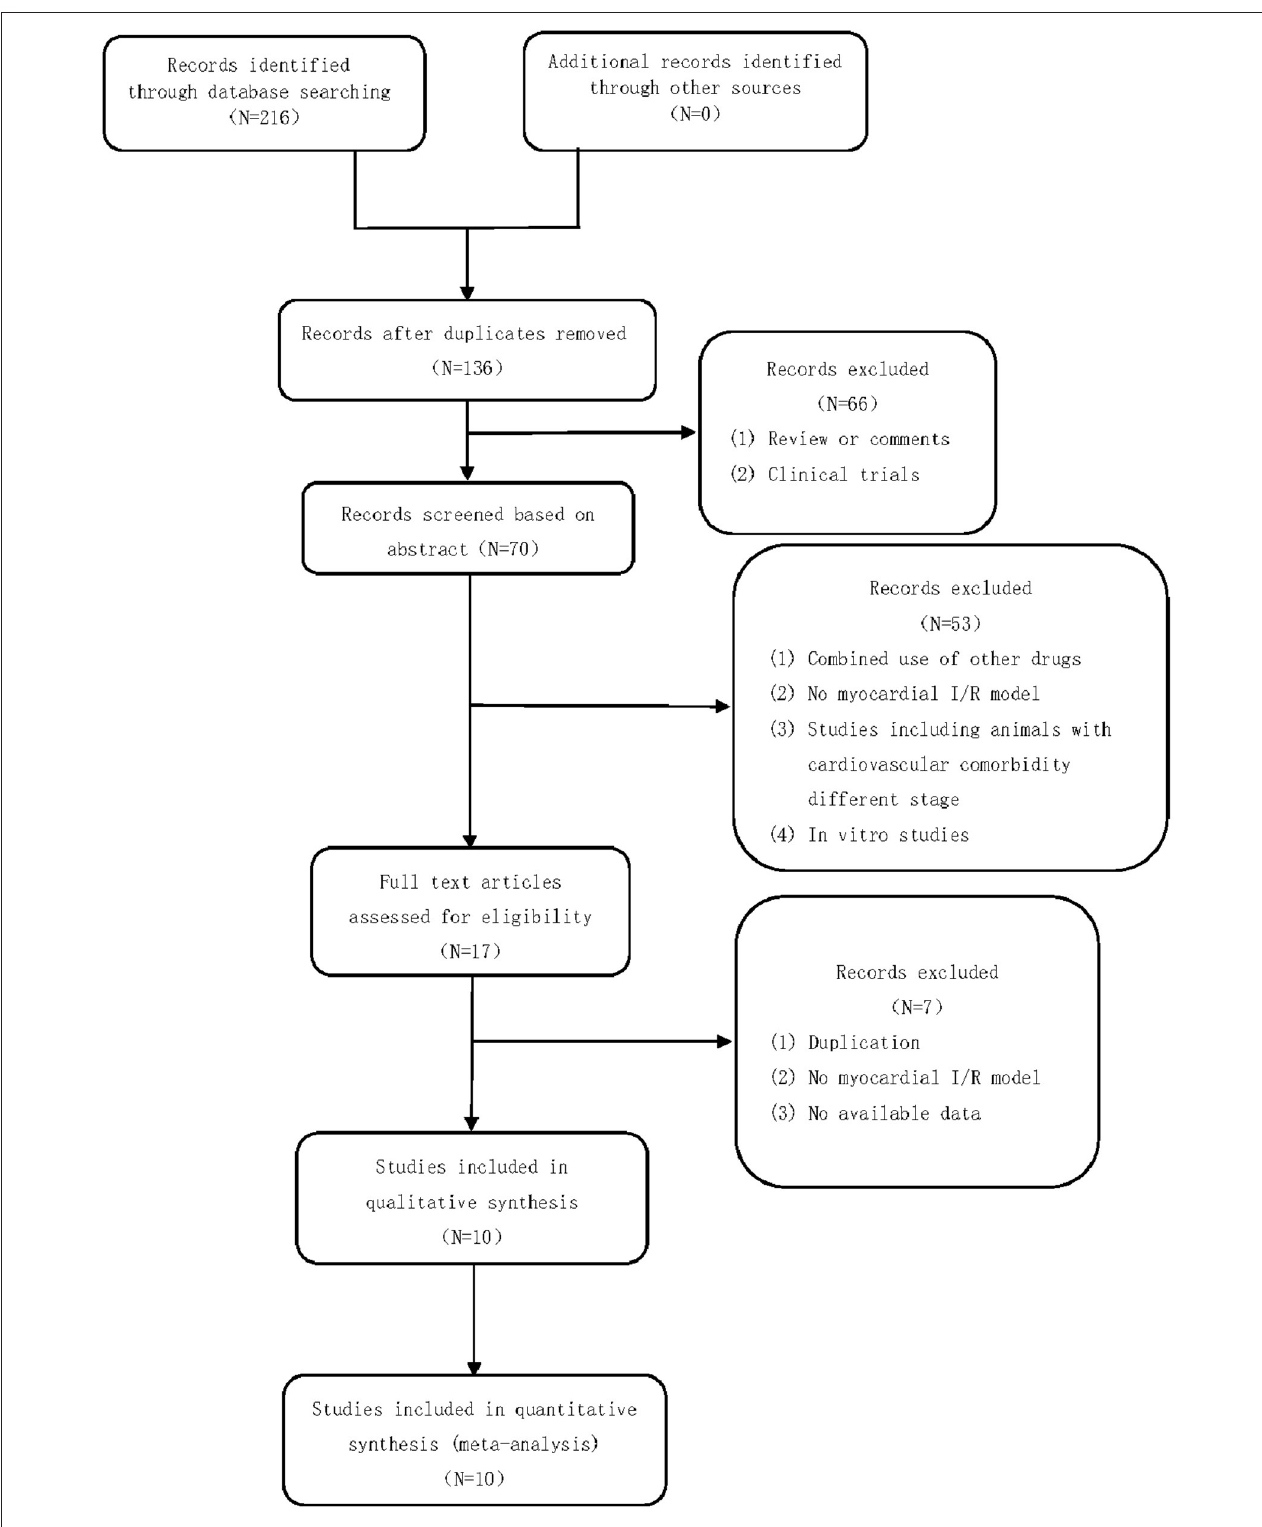
FIGURE 2 | Summary of the process for identifying candidate studies.